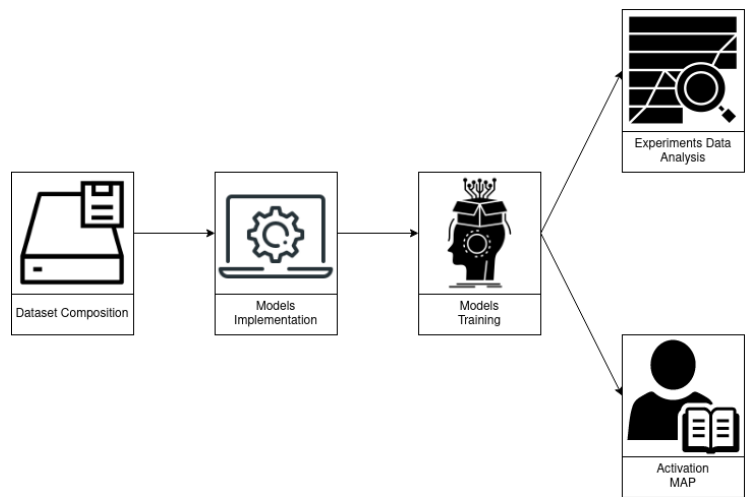
Figure 4. The workflow of the proposed method: starting from a dataset of Android applications, converted to grayscale images, a set of convolutional and quantum